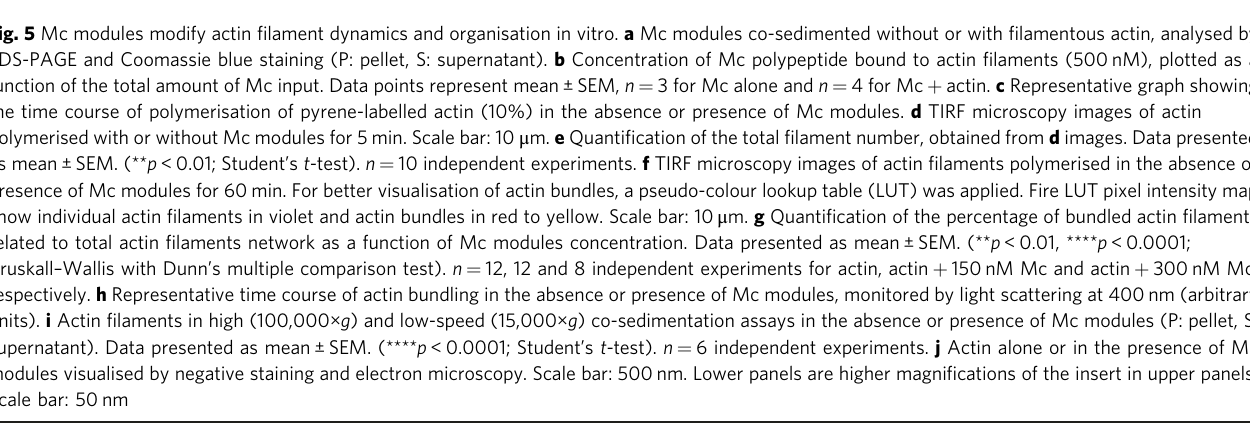
Fig. 5 Mc modules modify actin fi lament dynamics and organisation in vitro. a Mc modules co-sedimented without or with fi lamentous actin, analysed by SDS-PAGE and Coomassie blue staining (P: pellet, S: supernatant). b Concentration of Mc polypeptide bound to actin fi laments (500 nM), plotted as a function of the total amount of Mc input. Data points represent mean ± SEM, n = 3 for Mc alone and n = 4 for Mc + actin. c Representative graph showing the time course of polymerisation of pyrene-labelled actin (10%) in the absence or presence of Mc modules. d TIRF microscopy images of actin polymerised with or without Mc modules for 5 min. Scale bar: 10 μ m. e Quanti fi cation of the total fi lament number, obtained from d images. Data presented as mean ± SEM. (** p < 0.01; Student ’ s t -test). n = 10 independent experiments. f TIRF microscopy images of actin fi laments polymerised in the absence or